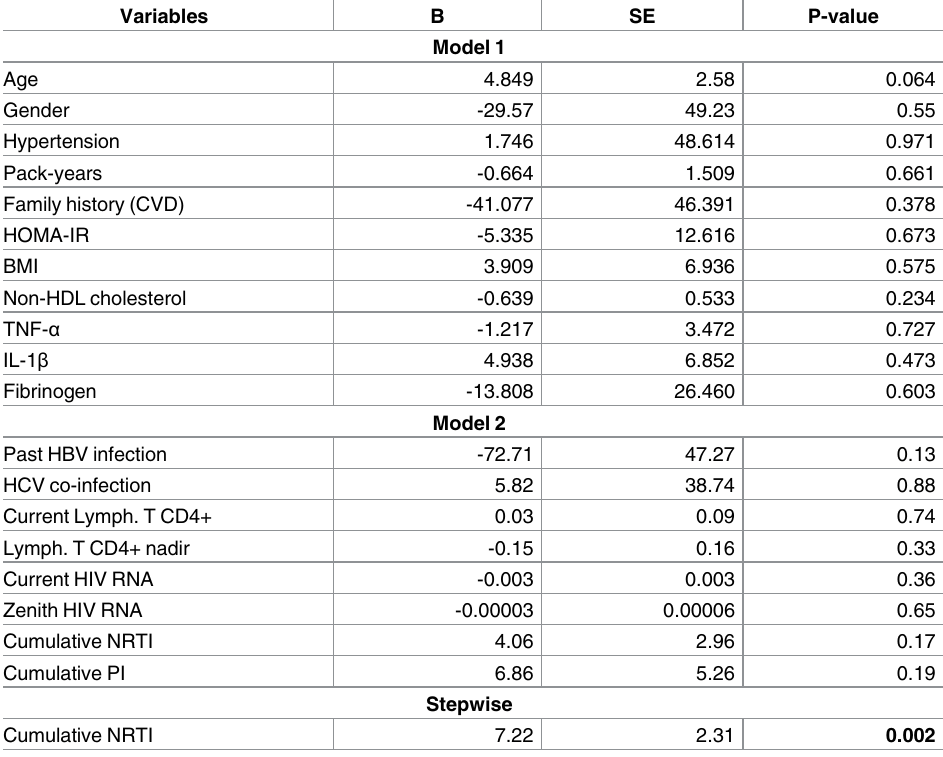
Table 4. Effect of traditional CVD risk factors, inflammatory markers(model 1), virological and immu- nological parameters, including cumulative antiretroviral PI and NRTI treatment (model 2), on the con- centrations of TF (multivariate regression).